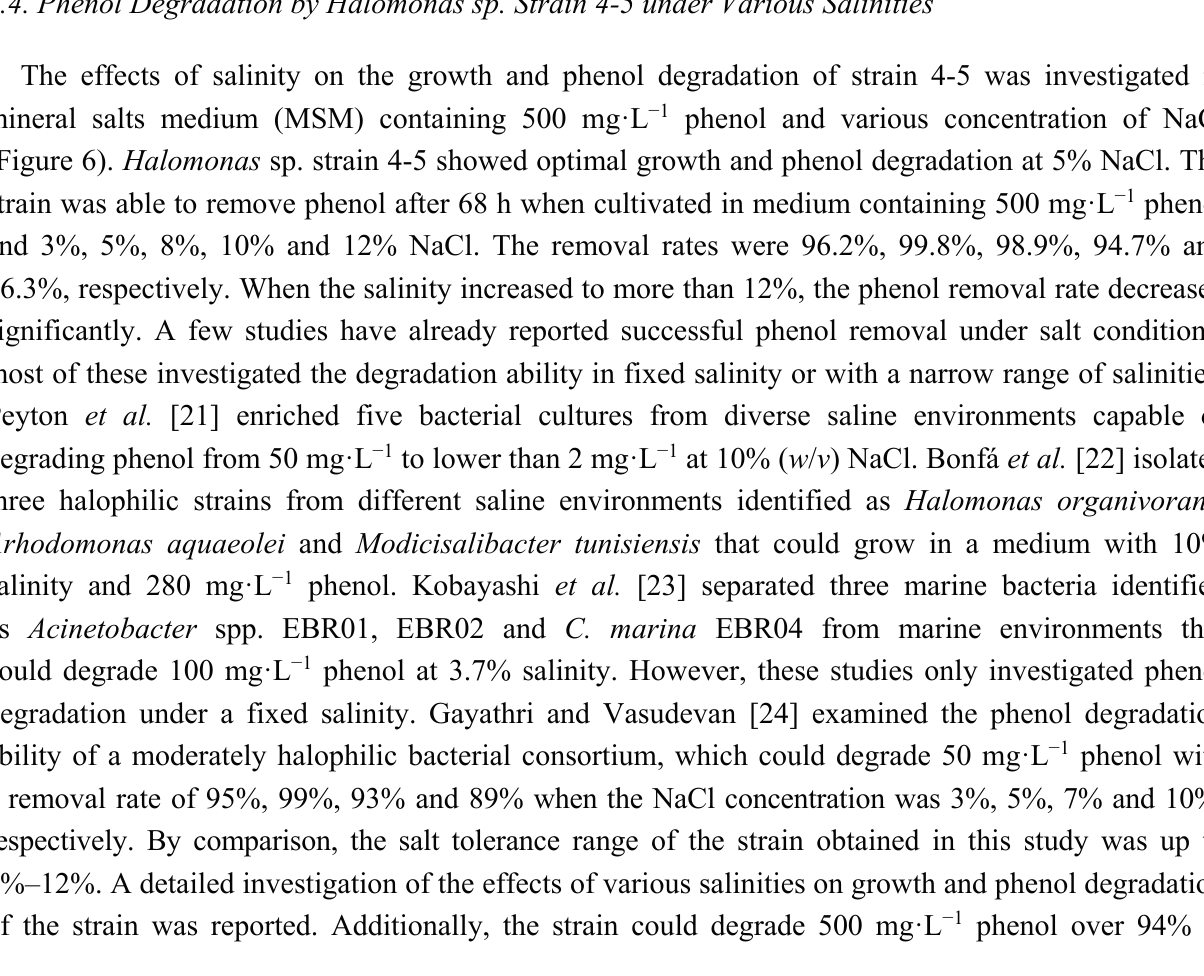
Figure 5. Phylogenetic tree based on 16S rRNA sequences, constructed by the neighbor-joining method, showing the position of strain 4-5 and representatives of some related strains. Pseudomonas putida NBRC 14671 was used as an out group. Bootstrap values were 1000 replicates, in which ≥ 50% were reported near the corresponding nodes. The scale bar indicates the percentage of genetic